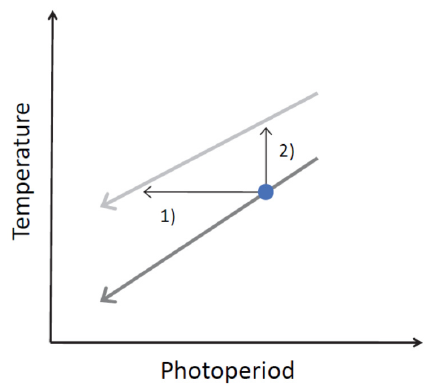
Figure 2. What is the optimal timing of cold acclimation and cessation of leaf growth in autumn? The grey arrows indicate the change in photoperiod and temperature during current (dark grey) and future (light grey) autumns. The timing of cold acclimation and cessation of leaf growth (blue dot) in the future climate could occur (1) at the same temperature as today, but shorter photoperiods (horizontal black arrow), or (2) at the same photoperiod as today, but warmer temperatures (vertical black arrow). Option (1) would allow higher biomass production, but cold acclimation and accumulation of sufficient carbohydrate reserves might be compromised by limited light energy.